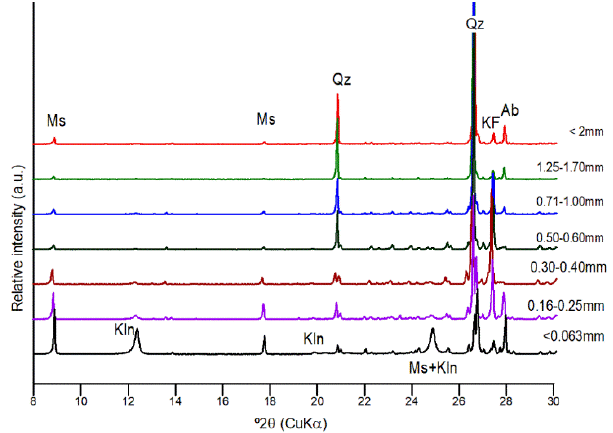
Figure 6. X-ray powder diffraction (XRD) diagrams showing the mineralogical composition of samples from the leucogranite (Pen-14) and from the Balsa Grande (Pen-8, Pen-9) and Balsa Pequeña tailings (Pen-16). Qz, quartz; Ab, albite, KF, K-feldspar; Ms, muscovite; and Kln, kaolinite.